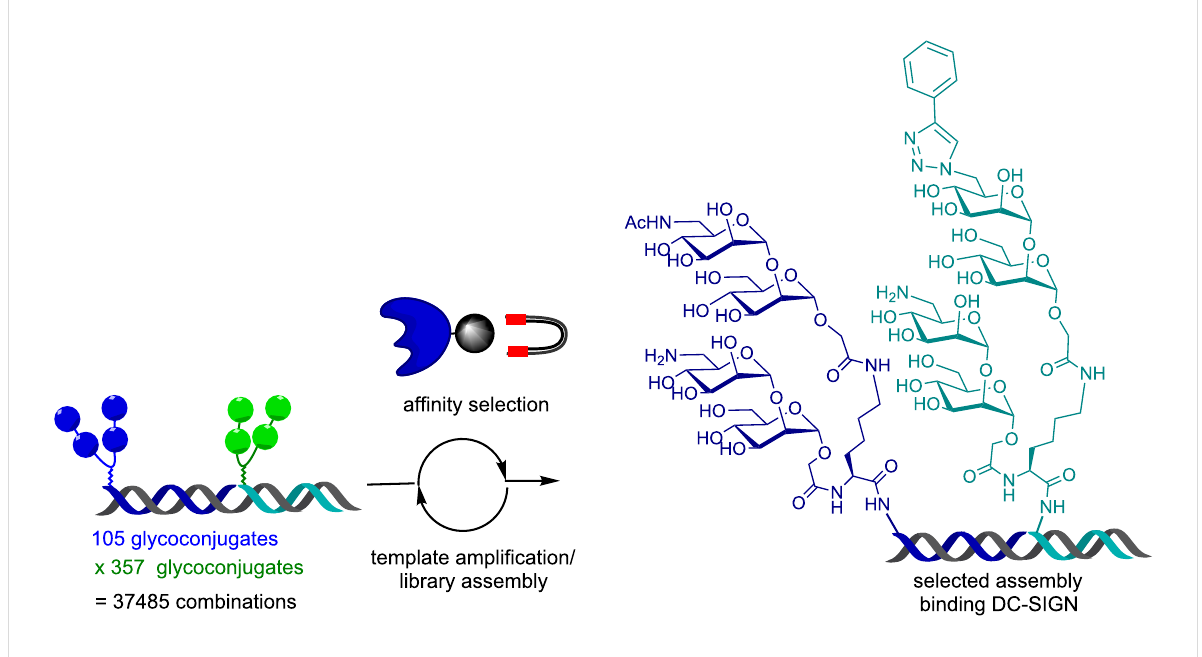
Figure 4: Combinatorial assembly and selection of two PNA glycoconjugate libraries on DNA templates.